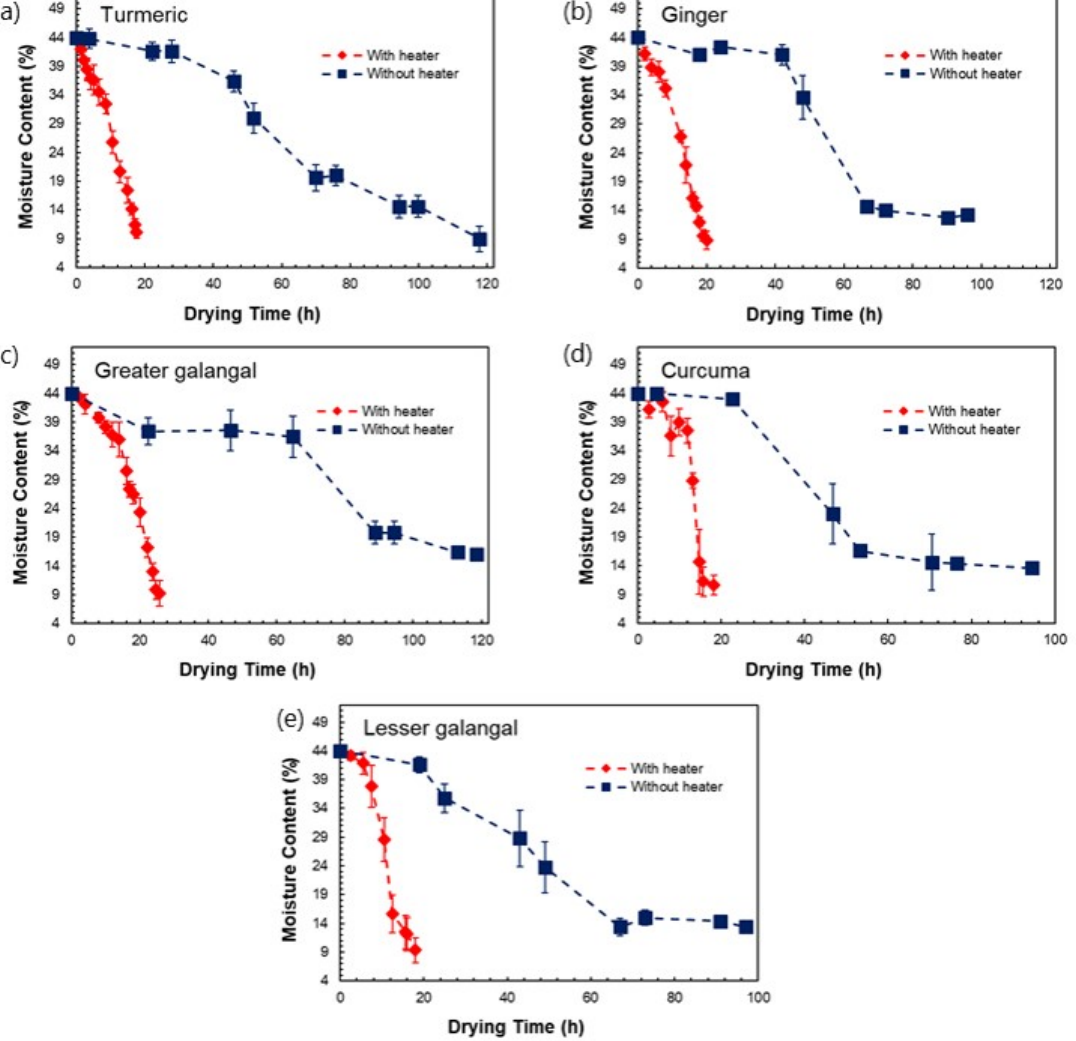
Figure 5. Drying profiles of medicinal plant samples in the Polydryer with and without the operation of a heater: ( a ) turmeric, ( b ) ginger, ( c ) greater galangal, ( d ) Curcuma, ( e ) lesser galangal. The graphs indicate that the employment of the heater greatly shortened the drying time of the samples. Rhizome drying in the Polydryer without heater operation required 95–119 h to attain a moisture content of 9.0–16.0%, as summarized in Table 2. Meanwhile, the Polydryer with the heater needed 18–26 h to reach a moisture content of 8.8–10.7%. The initial moisture content measured using the gravimetric method of all samples showed an initial moisture content of 73.2–89.2%, which caused a variation in drying time from one sample to another. A higher initial moisture content tended to prolong the drying time of the materials